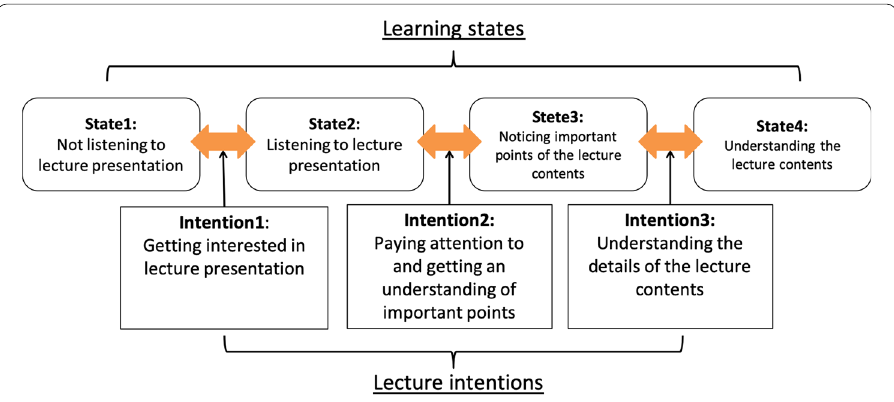
Fig.1 Relationships between learning states and lecture